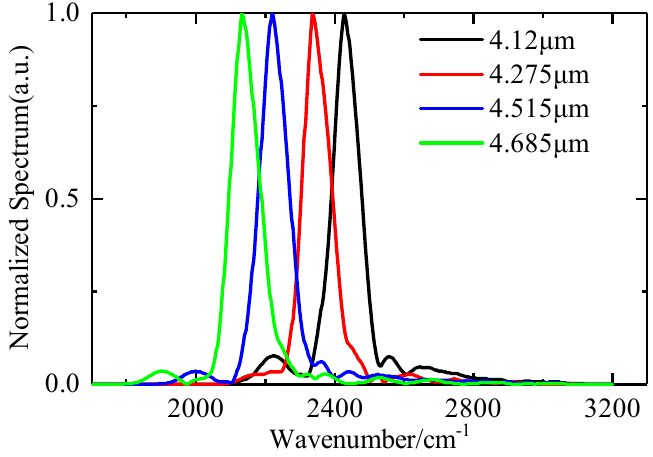
Figure 15. Normalized spectra of filter set after wavenumber calibration. The central wavenumbers of the calibrated spectrum were 2427.3 cm − 1 , 2339.3 cm − 1 , 2214.9 cm − 1 , and 2134.7 cm − 1 , and the average error from the theoretical value was only